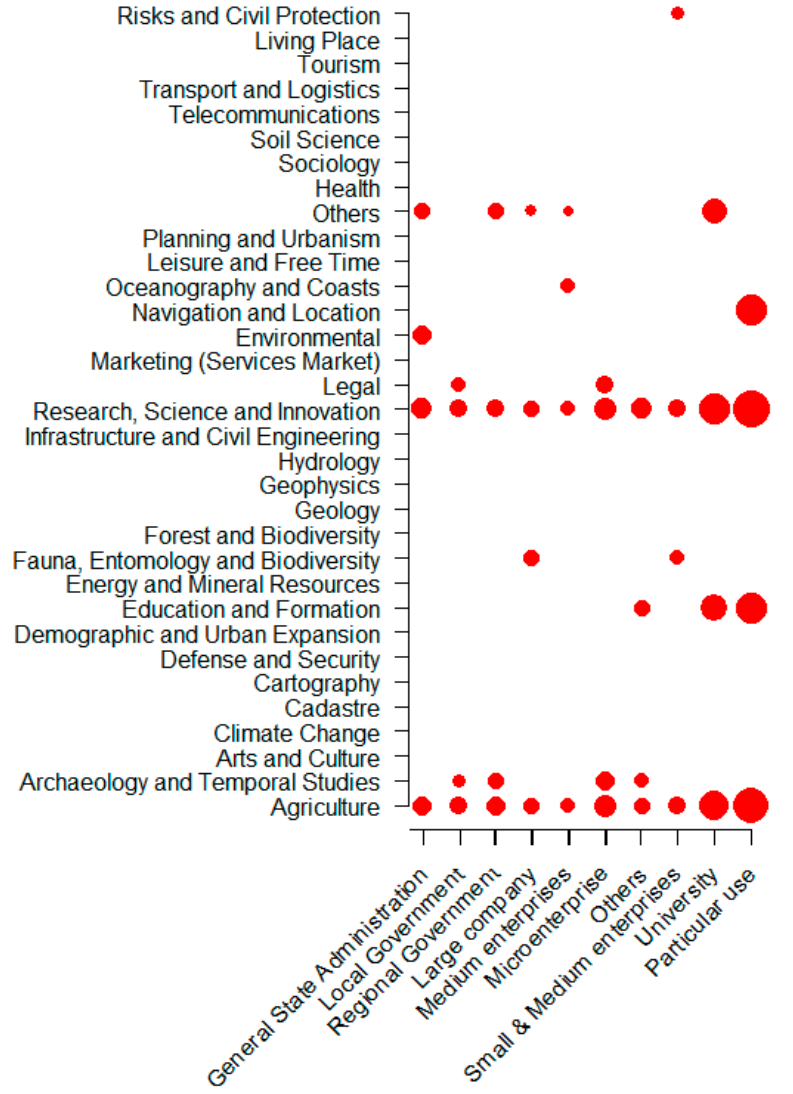
Figure 3. The relation between user profile and sectors (thematic area).